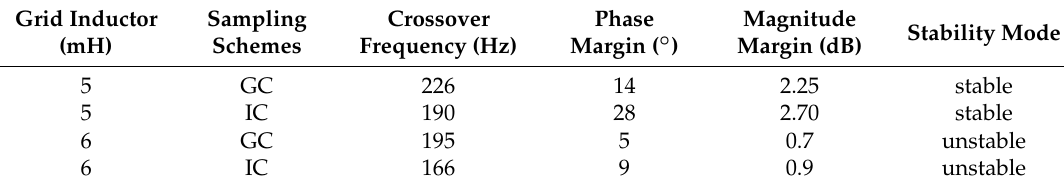
Table 2. Stability referring to different current sampling schemes.